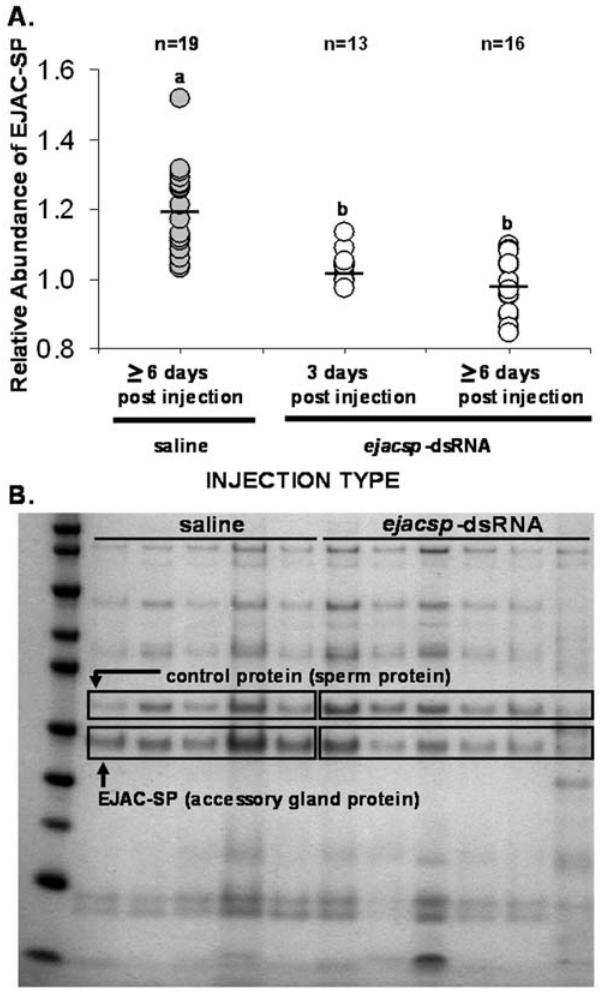
Figure 4. RNAi and the knockdown of EJAC-SP protein in the male ejaculate. The relative abundance of EJAC-SP protein in saline- and ejacsp -dsRNA-injected males at three and/or six days post-injection (A; a and b refer to statistically different groups based on post-hoc tests, P , 0.00001). The gel (B) is a representative 1D-SDS PAGE gel of proteins from individual spermatophores from males in both the saline- and ejacsp -dsRNA treatments at $ 6 days post-injection. The EJAC-SP protein and the protein used as a control are outlined in boxes.